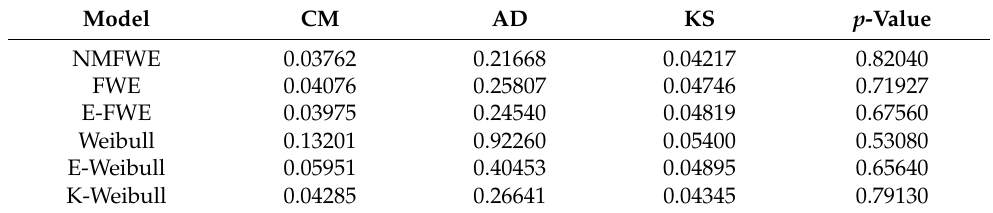
Table 9. The values of CM, AD, and KS of the fitted models, using the second COVID-19 dataset. Model CM AD KS p -Value NMFWE 0.03762 0.21668 0.04217 0.82040 FWE 0.04076 0.25807 0.04746 0.71927 E-FWE 0.03975 0.24540 0.04819 0.67560 Weibull 0.13201 0.92260 0.05400 0.53080 E-Weibull 0.05951 0.40453 0.04895 0.65640 K-Weibull 0.04285 0.26641 0.04345